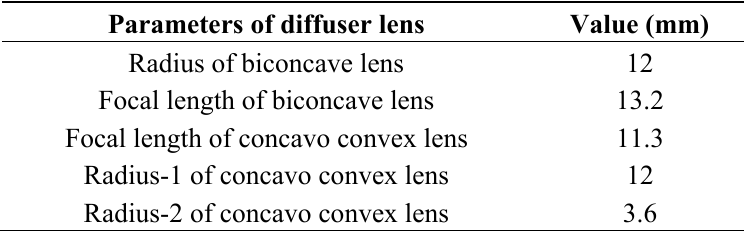
Figure 2. ( a ) Scheme of the proposed daylighting system; ( b ) Schematic diagram of the design to produce collimated illumination. Table 1. Different parameters of hardware